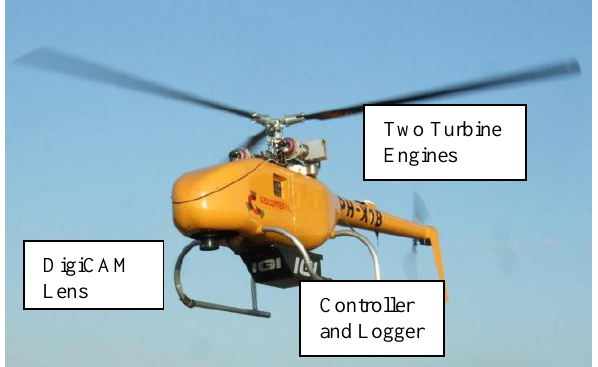
Figure 2. Geocopter GC-201 UAS-g with IGI DigiCAM and